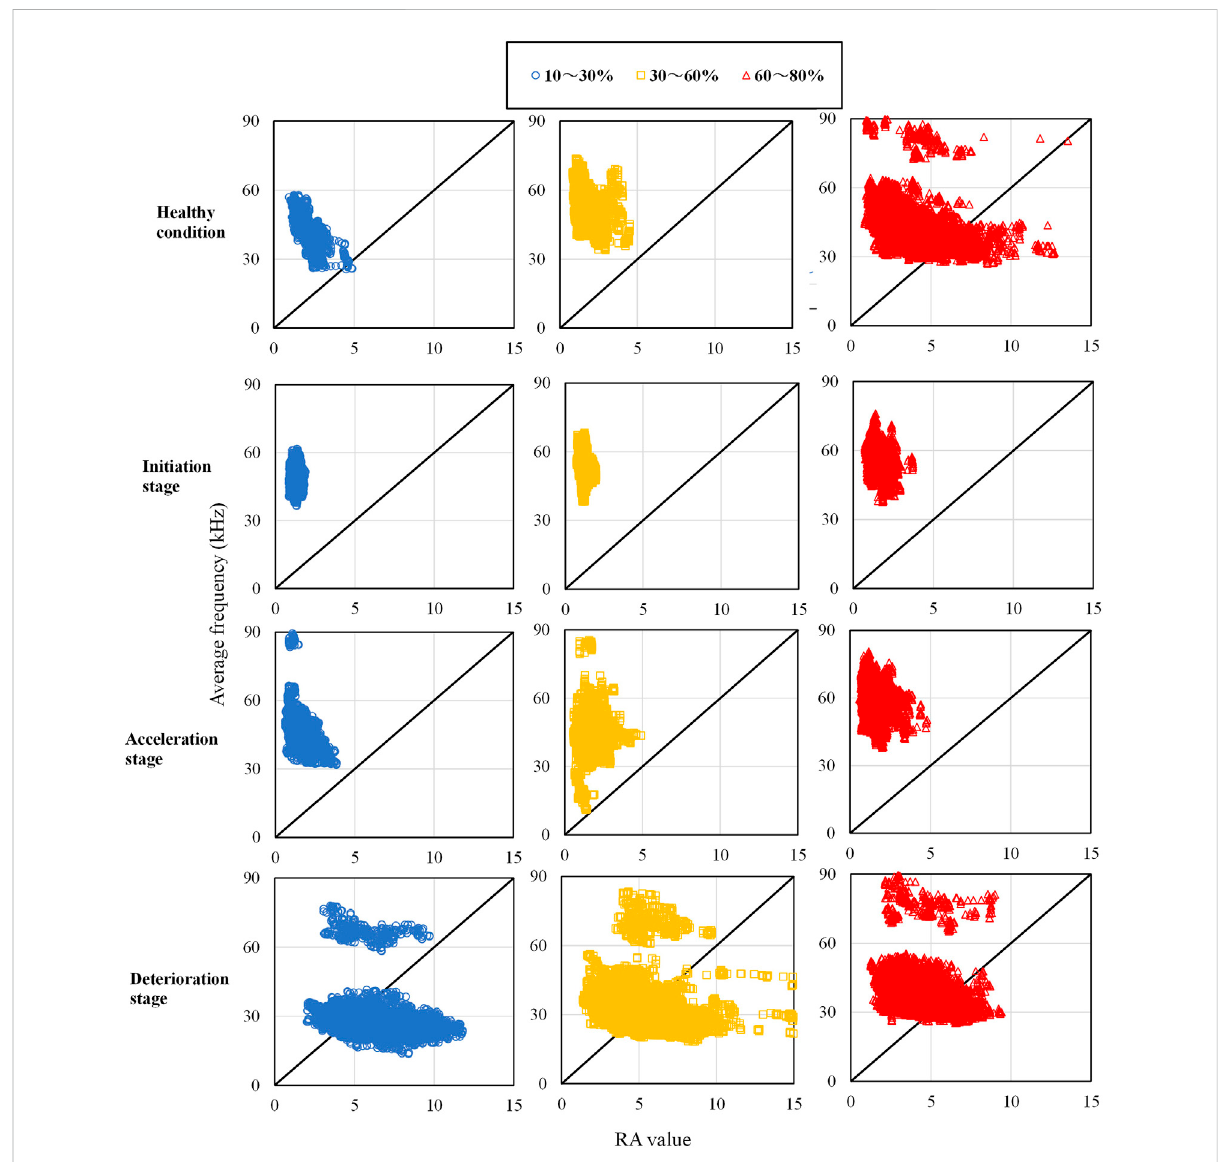
FIGURE 14 Relationship between RA values and average frequencies in uncoated